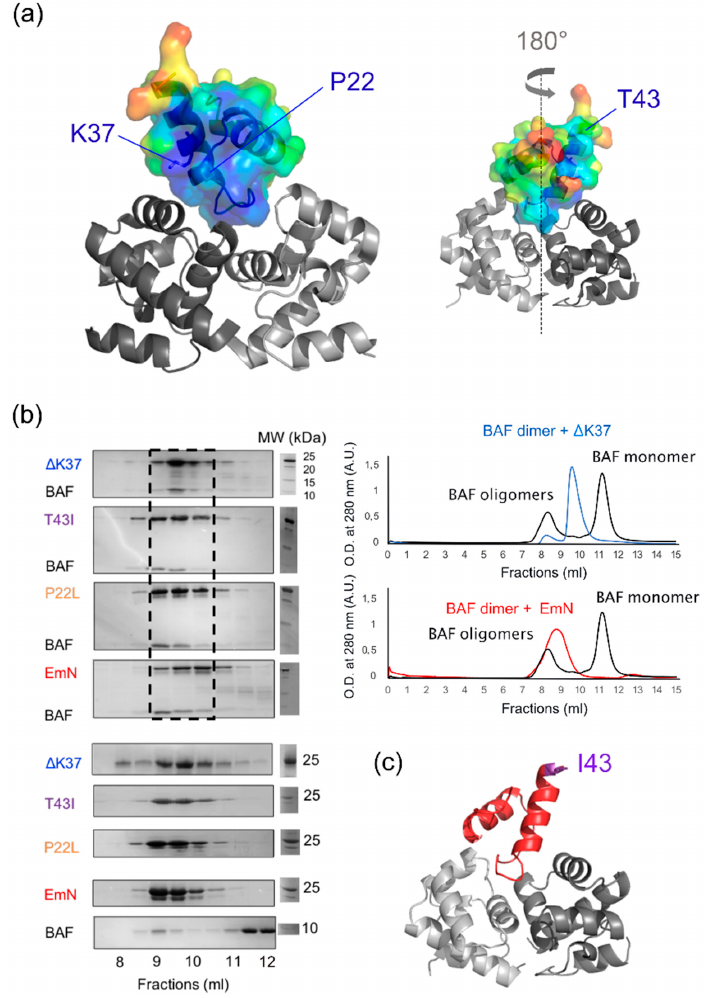
Figure 3. The three emerin mutants interact with the barrier-to-autointegration factor (BAF) in vitro. ( a ) Molecular surface representation of the LEM-domain (color gradient) docked to its binding site within the BAF dimer (grey cartoon), in two orientations (180° rotation, as indicated). Lysine 37, proline 22 and threonine 43 are indicated with blue arrows. Color gradient represents LEM sequence conservation (highly conserved in blue to poorly conserved in red). ( b ) Size-exclusion chromatography was performed on EmN wild-type and mutants, in the absence and presence of BAF, in order to obtain reference and binary-complex chromatograms, respectively. In all experiments, proteins were injected at the same concentration (100 µM EmN, 200 µM BAF), using the same buffer and column (Superdex 75 10/300 GL). Left panel: SDS-PAGE gels corresponding to references and binary-complex chromatograms are presented, from bottom: References for BAF (black), EmN (red), P22L (orange), T43I (purple) and ∆ K37 (blue) followed by EmN-BAF, P22l-BAF, T43I-BAF and ∆ K37-BAF binary complexes. Bands corresponding to the four binary complexes are boxed (black dotted rectangle). Right panel: Chromatograms representing the elution fractions of BAF alone are shown in black, binary complexes of ∆ K37-BAF in blue and wild-type EmN-BAF in red. ( c ) The 3D structure of the LEM-domain (red) of mutant T43I (threonine 43 in purple) bound to the BAF dimer (grey) resolved by X- ray crystallography at a resolution of 2.3 Å (conditions: 18% PEG 3350, 100 mM Tris Bis pH 5.5, 0.1 M NH 4 SO 4 ; Table